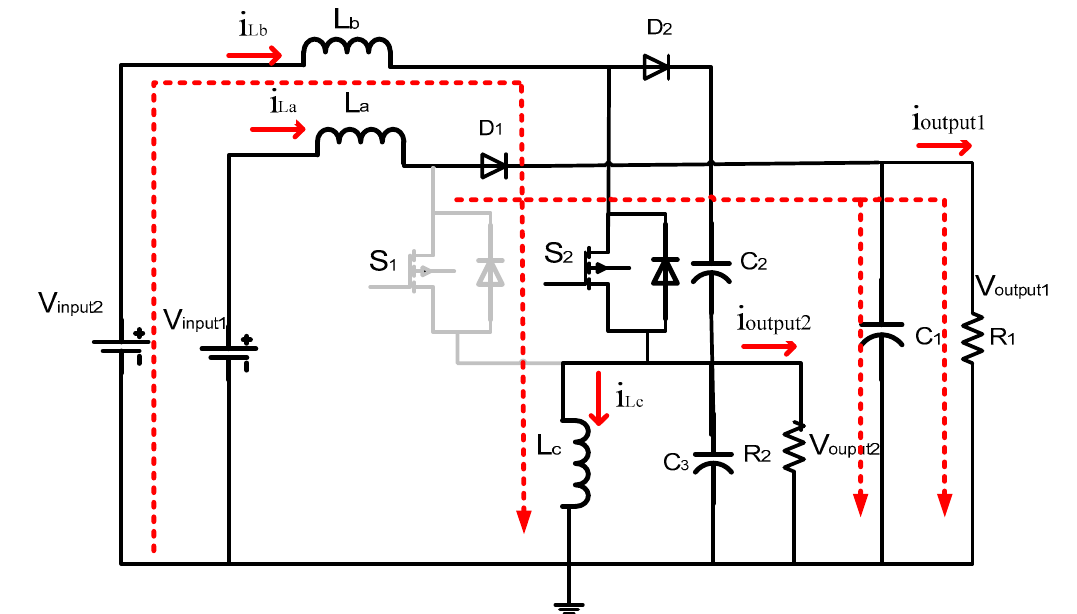
Figure 4. Mode 2 operation ( ---- Current flow direction).